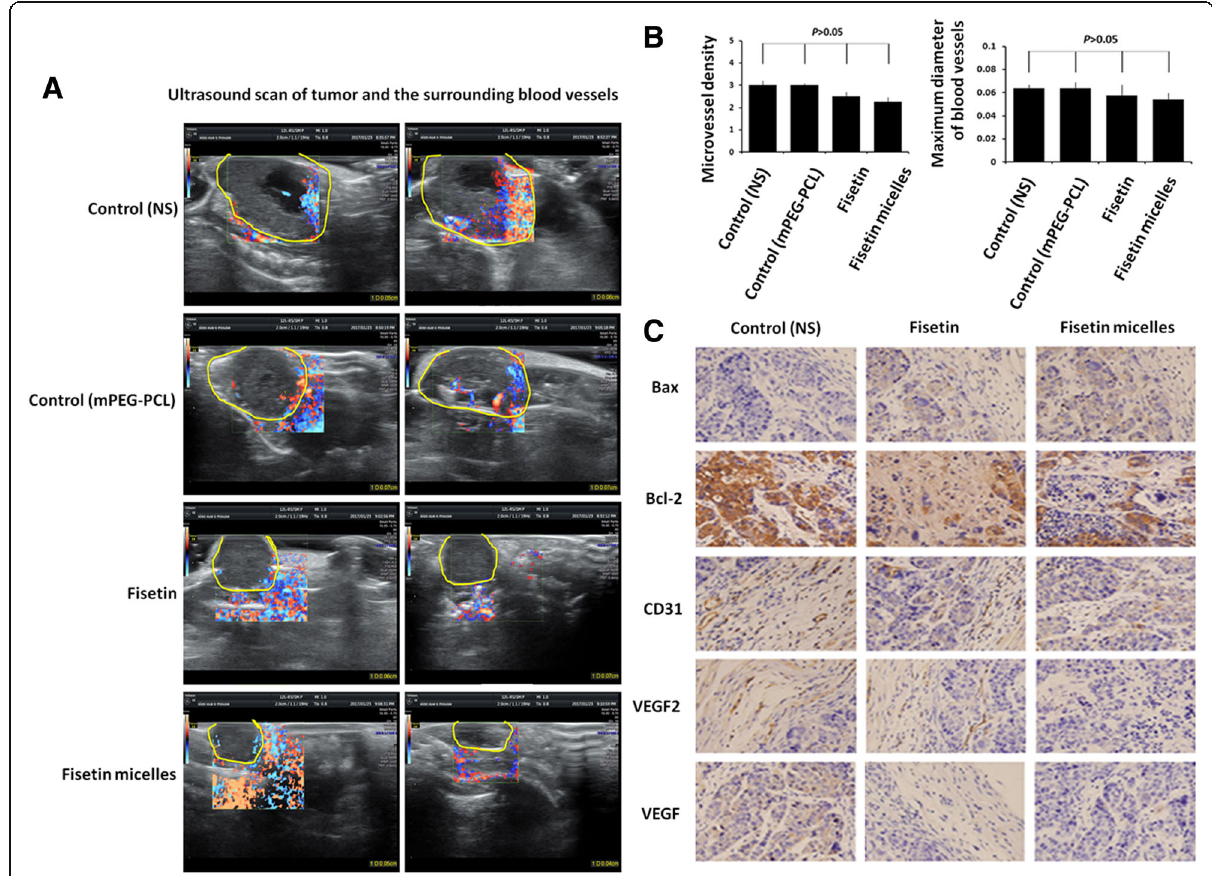
Fig. 6 Fisetin treatment suppresses the tumor growth and tumor angiogenesis. a Representative images of the implanted tumors and vessels in the fisetin-treated and control mice monitored by a Philips HD11 ultrasound scanner equipped with an 11 MHz linear array transducer are shown in this figure. Yellow dotted line defined the tumor location. The red and blue color indicates flows toward and away from the ultrasound transductor of blood vessels and microvessel density deduced from the ultrasound signals from randomly chosen planes indicates that fisetin/fisetin micelles treatment affects the tumor blood vessel characteristics in SKOV3 ovarian tumor xenografts. b Columns, means ( n =3); bars SE. c Representative images of random sections of the grafts from fisetin/fisetin micelles treated or control mice were labeled with marker for blood vessel marker CD31 and VEGFR2 and subjected to H&E staining (images were recorded at the magnification of ×200). Figures demonstrated that fisetin/fisetin micelles treatment compromises blood vessel network and VEGFR2